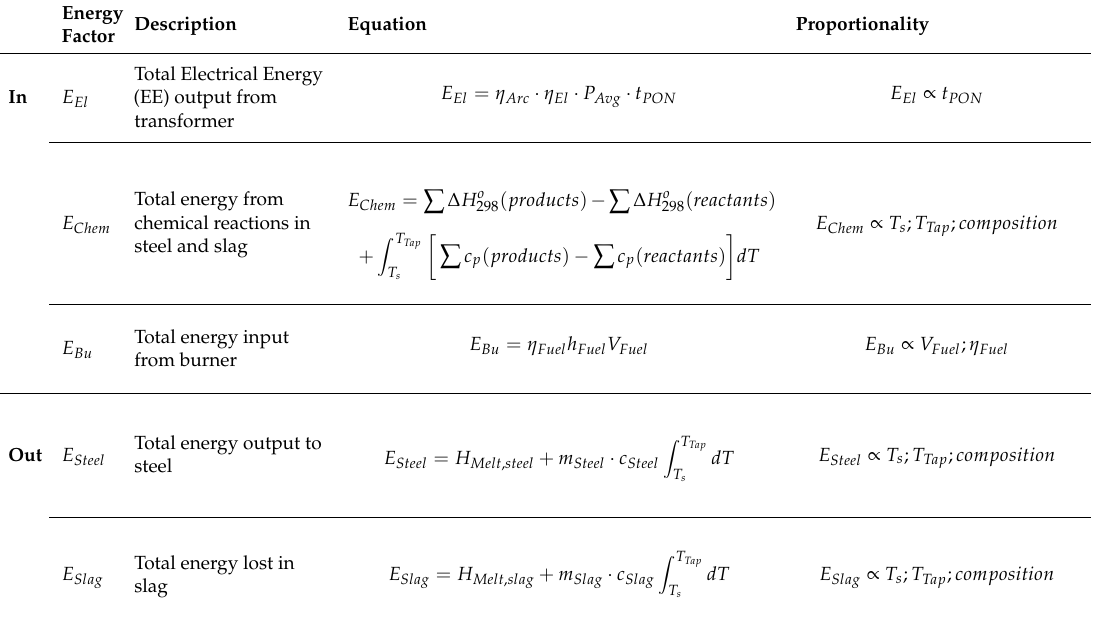
Table 1. Ingoing and outgoing energy terms governing the energy balance equation of the Electric Arc Furnace (EAF)